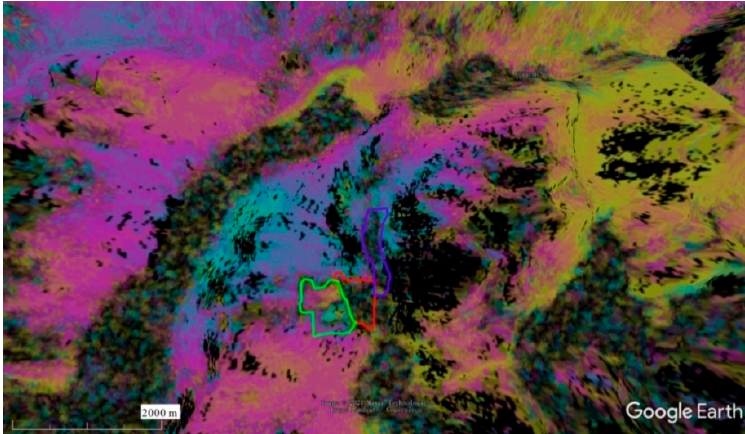
Figure 7. Sidling zone detected based on the wrapped interferogram. The red polygon is the same (suspected) collapsed area outlined in Figure 6. The green polygon denotes a slow sliding area above the collapsed zone.